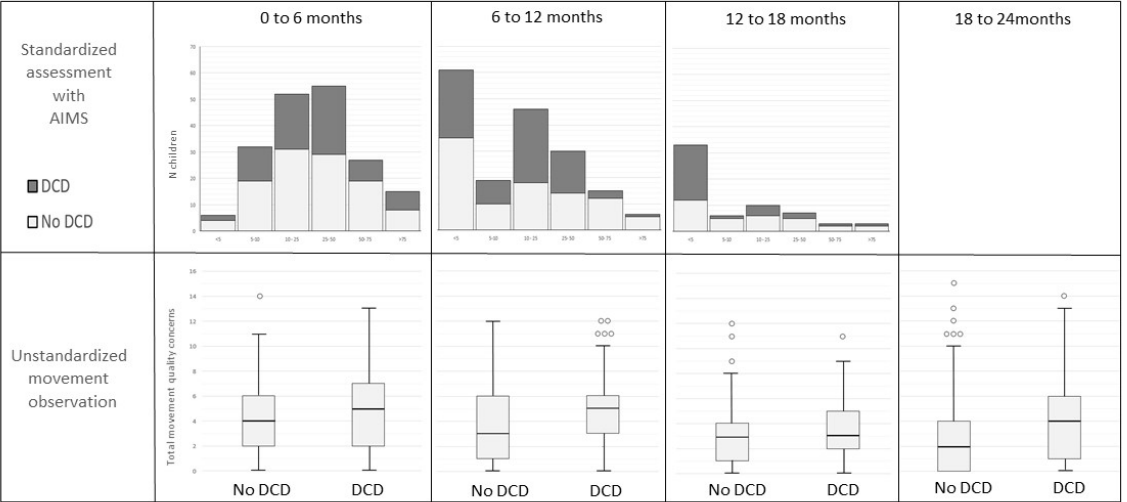
Figure 2. Prevalence of DCD diagnoses after 3 years in the different age groups in relation to percentile ranges of AIMS scores and to the number of movement quality concerns.